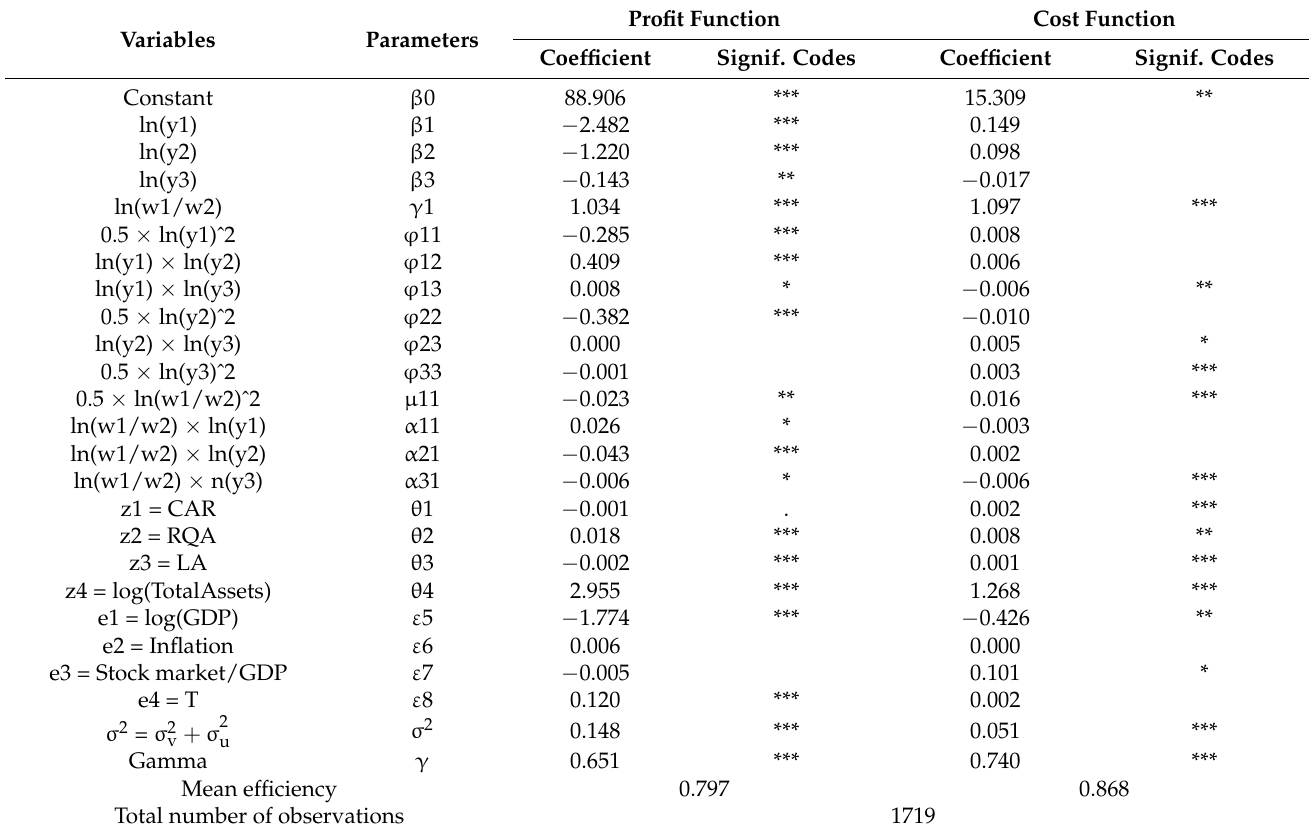
Table 5. Parameter estimates for stochastic frontier profit function and cost